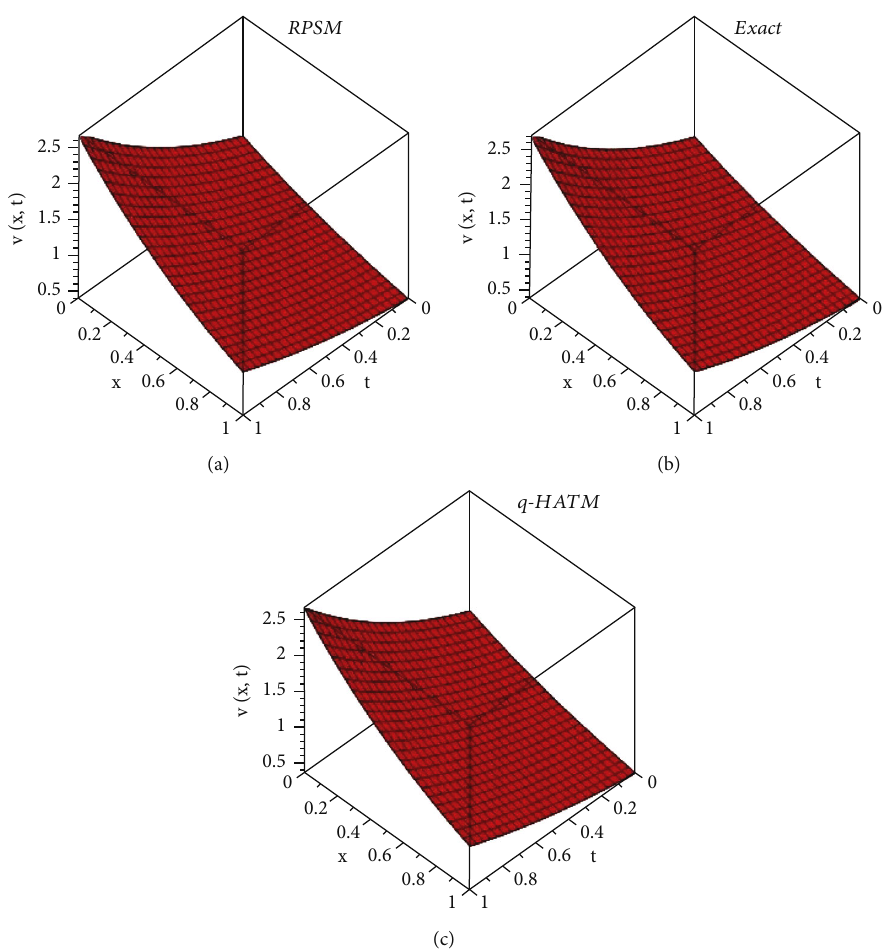
Figure 1: 3D plots of (a) RPSM, (b) Exact, and (c) q-HATM υ − solutions at δ = 1 of Example